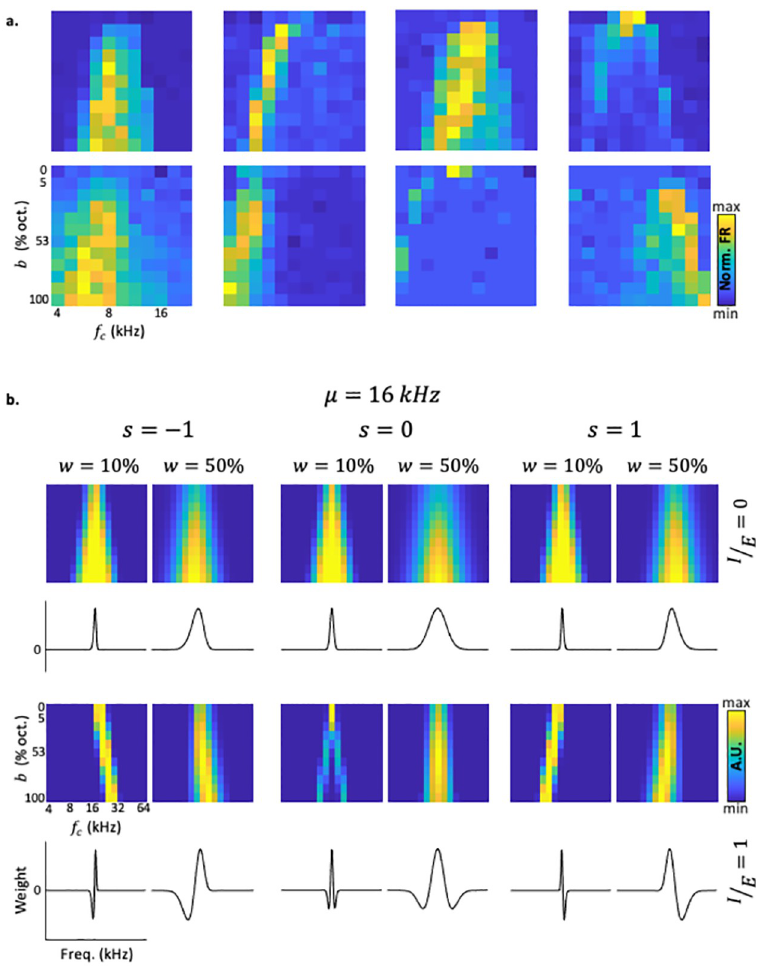
Fig 2. Frequency Bandwidth Response Areas (FBRAs) of neurons and the model. a. FBRAs of 8 example neurons from 5 different mice. b. Model-FBRAs (top) and corresponding tuning curves (bottom) of 12 examples as calculated from the model. The examples span varying s , I = and w E